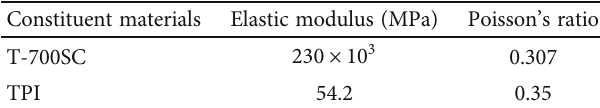
Table 1: Constituent material